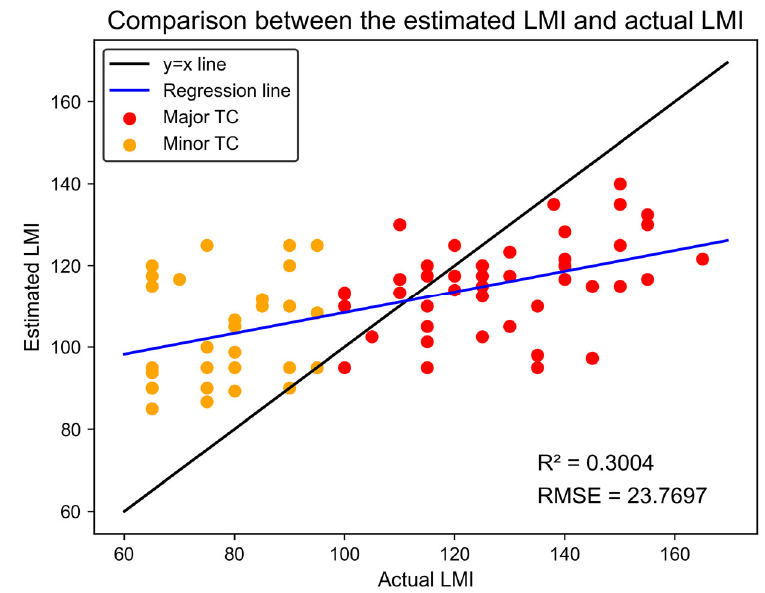
Figure 9. Comparison between estimated and actual LMI (knots) in the testing set, colored according to actual LMI (red for major and yellow for minor TC). Black line is y = x and blue line is regression line of estimated values. Values of metrics for evaluating fitting are in the lower right. Correlation is statistically significant at the confidence level of 99%.